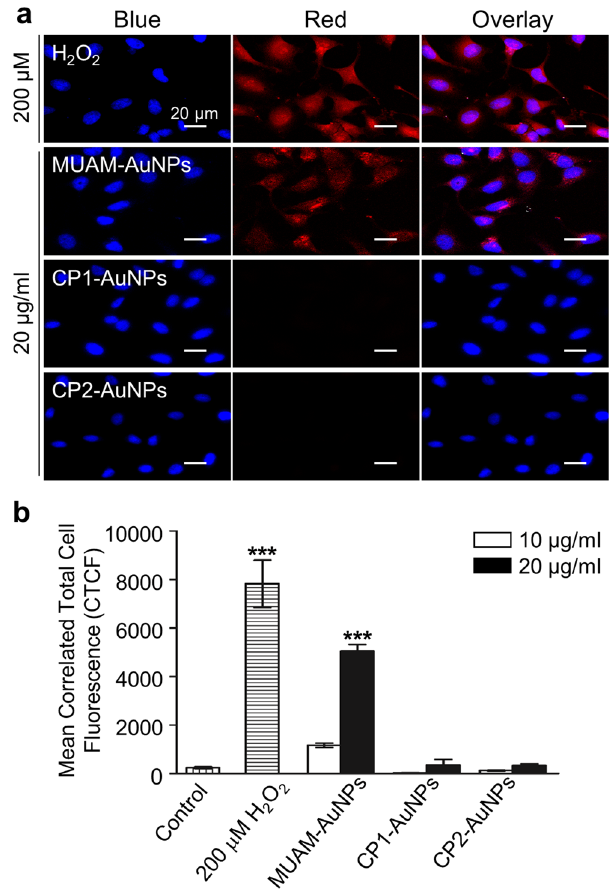
Figure 5. Reactive oxygen species generation induced by cationic gold nanoparticles (AuNPs). ( a ) The level of ROS generation in cationic AuNPs-treated cells were monitored. MUAM-AuNPs treated cells showed increased ROS level comparable to H 2 O 2 -treated control group, while other cationic AuNPs did not induce noticeable ROS generation. Scale bar: 20 μ m. ( b ) The fluorescence intensity shows the amount of ROS in AuNPs-treated cells. The level of ROS increased as the concentration of MUAM-AuNPs increased ( *** p < 0.001 , one-way